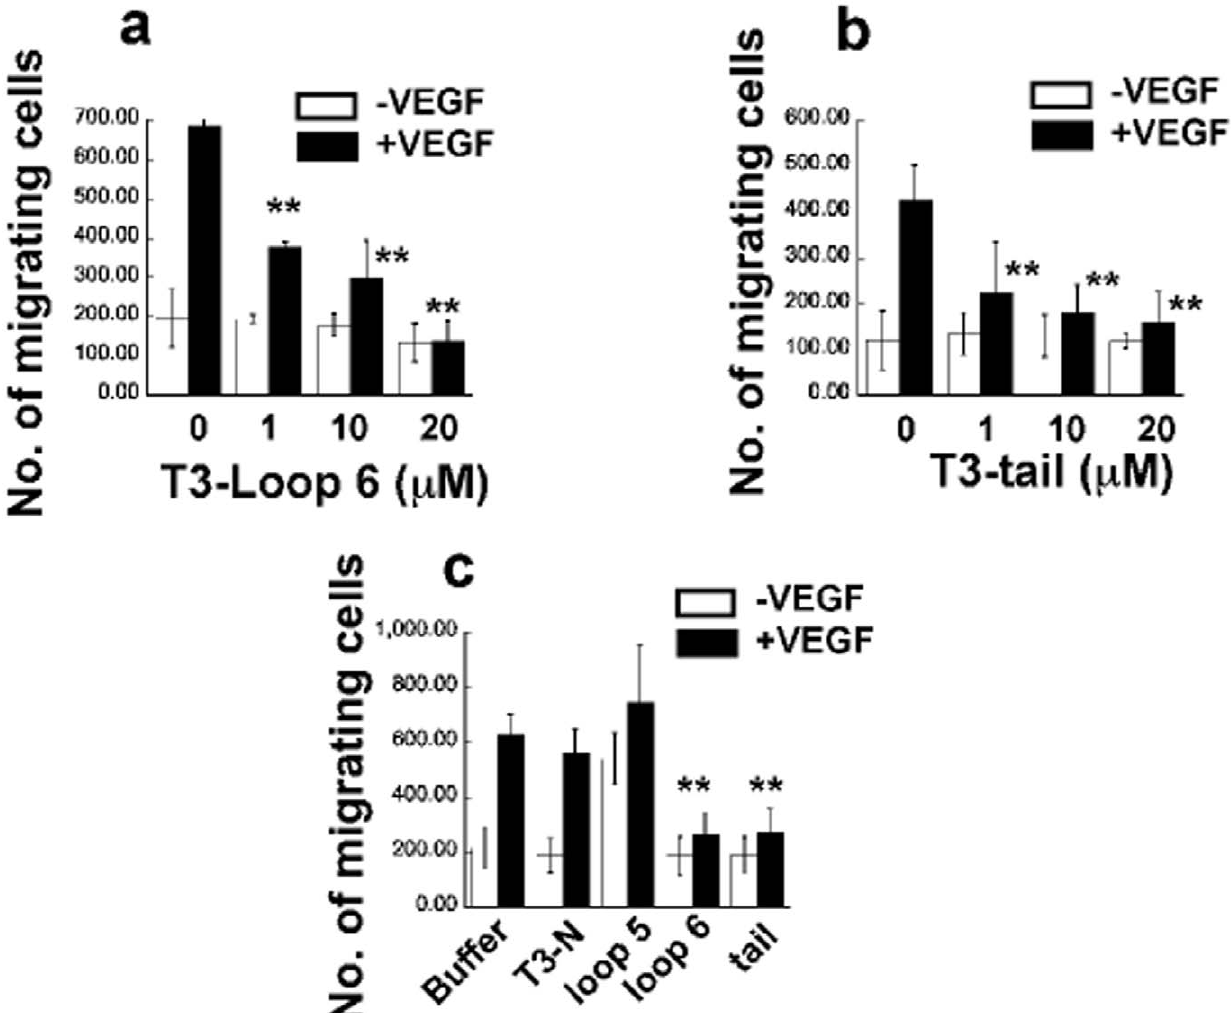
panel). Western blot analysis of the same blot with antibodies directed against the C-terminus of VEGFR-2, determined that there was no effect of the peptides on VEGFR-2 levels on the surface of endothelial cells (Fig. 3a, lower panel). To quantitate phosphorylation of VEGFR-2, densitometry of the phosphorylated